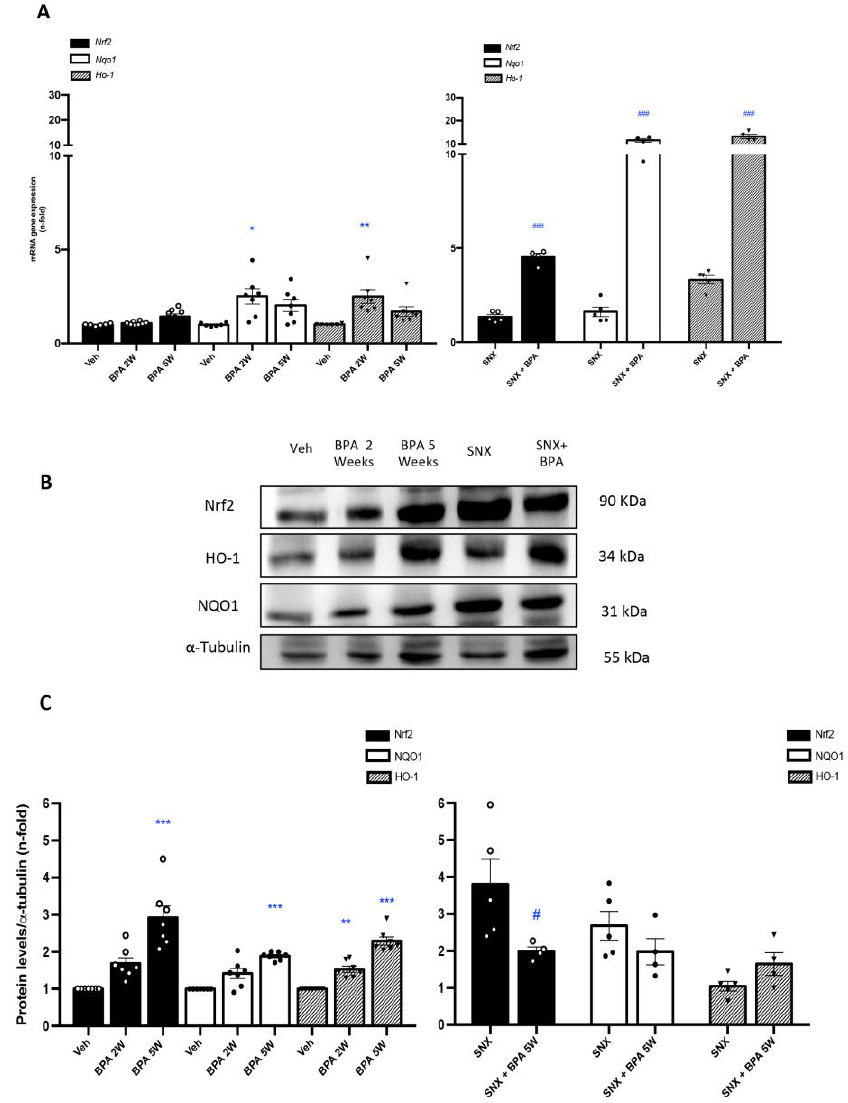
Figure 3. Systemic chronic administration of BPA activates Nrf2 pathway in SNX model of renal damage. Animals were intraperitoneal injected with 120 mg/kg/day BPA (5 days a week) or vehicle (corn oil) and sacrificed after 2 or 5 weeks. Some animals were subjected to subtotal nephrectomy (SNX), then treated or not with BPA and sacrificed after 5 weeks. ( A ) mRNA expression of Nrf2 and Nrf2-regulated genes: Nqo-1 Ho-1 evaluated by RT-PCR in renal tissue. ( B , C ) Representative Western blot image and the quantification of Nrf2, NQO1 and HO-1 levels in renal tissue lysates. All data are presented as the mean ± SEM of 4–7 mice per group, * p < 0.05; ** p < 0.01; *** p < 0.001 vs. Vehicle, # p < 0.05; ### p < 0.001 vs. SNX. Comparison between SNX and SNX + BPA groups was